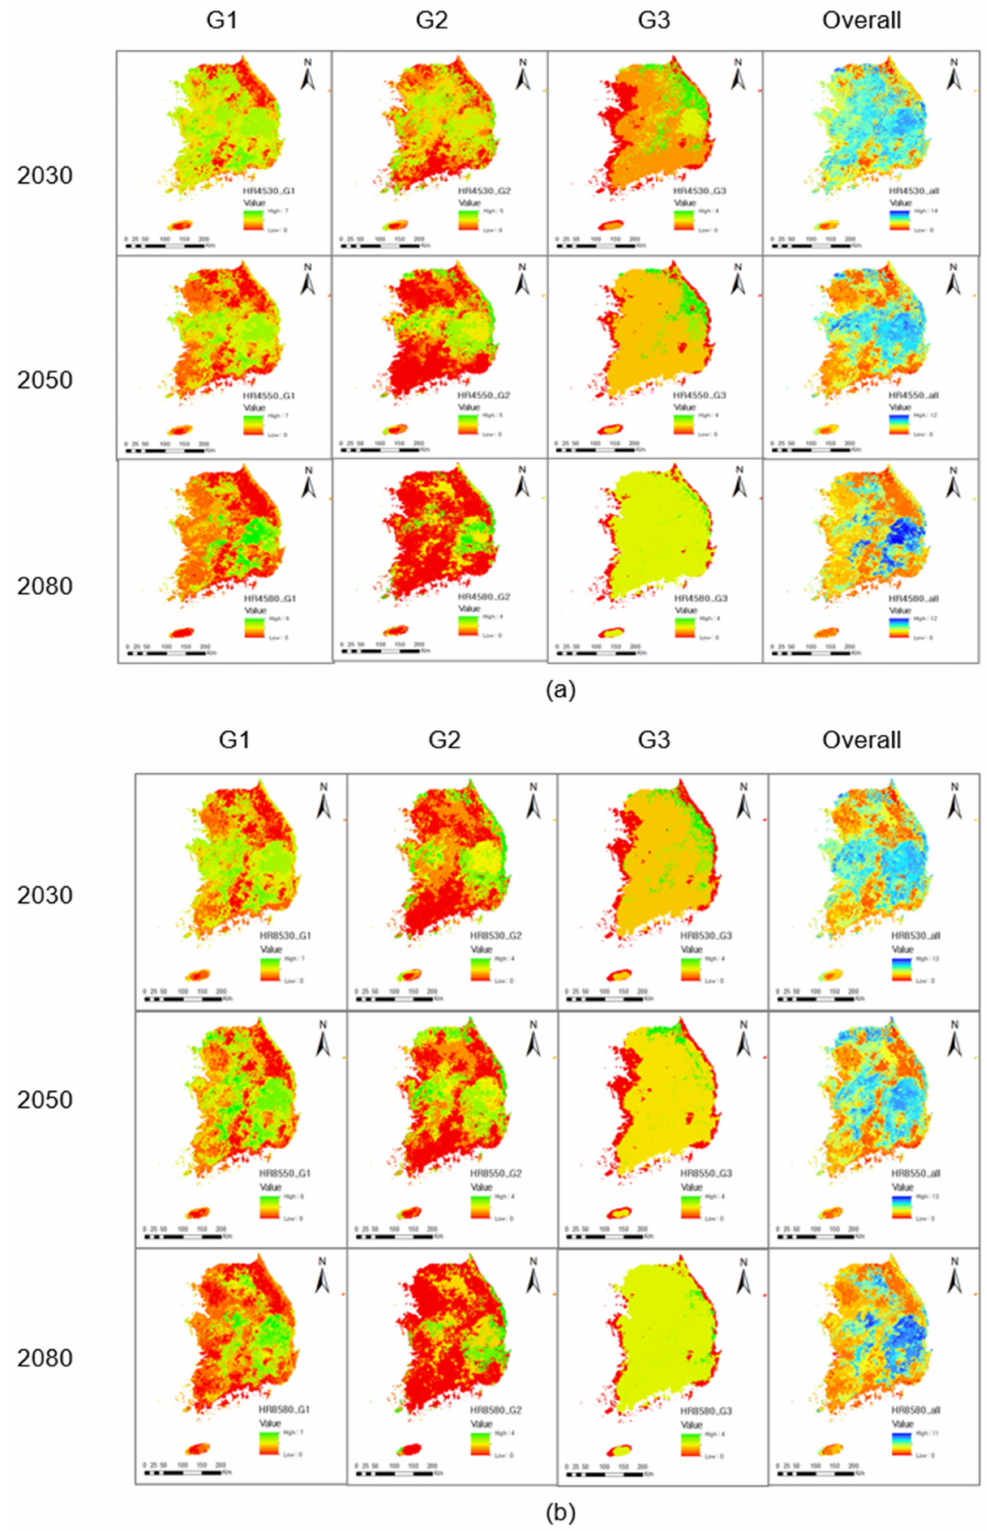
Figure 5. Potential species richness of amphibian under the future climate change: ( a ) RCP 4.5 ( b ) RCP